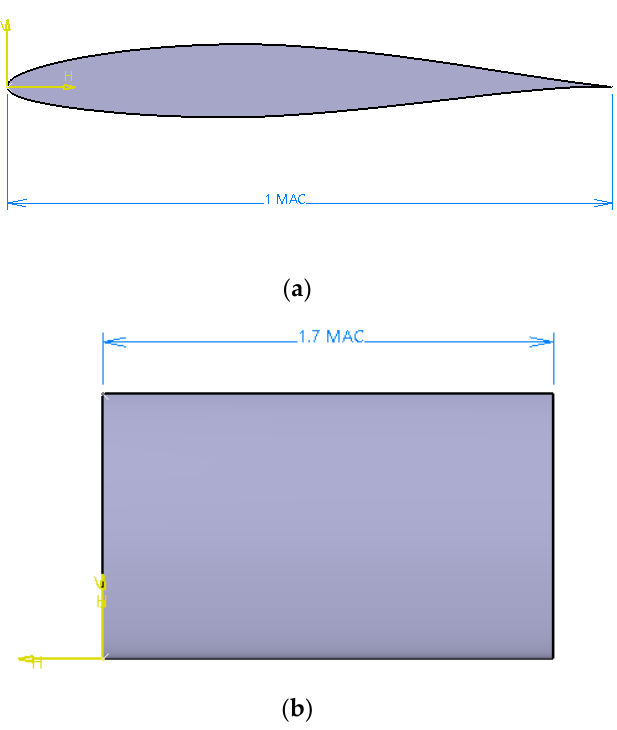
Figure 1. ( a ) Side view of the designed wing; ( b ) top view of the designed wing.